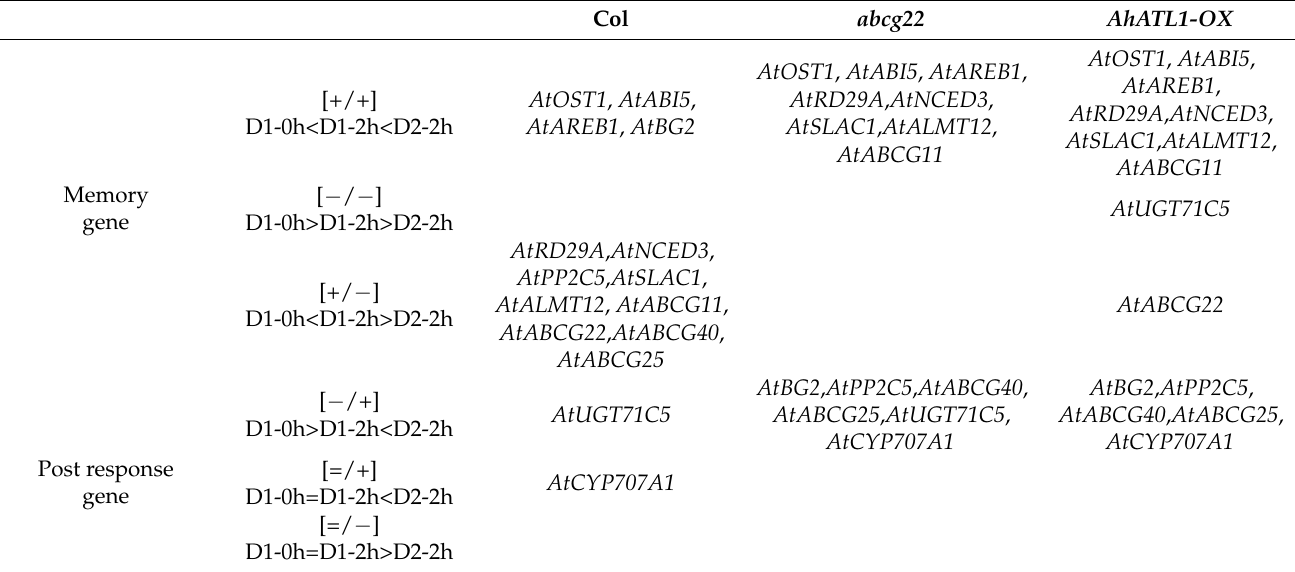
Table 1. Classification of the ABA and stress response-related genes under drought training.